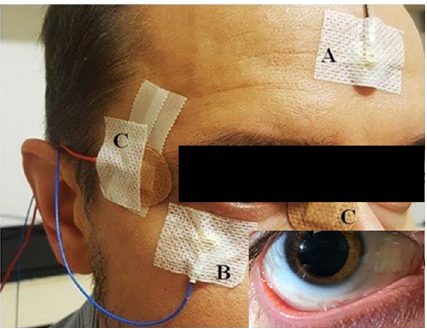
Figure 6. Illustrative position of the electrodes for ERG measurements. ( A ) Gold-cup ground electrode; ( B ) God-cup reference electrode; ( C ) DTL active electrode. For illustration purpose, small picture insert shows the position of the DTL electrode in the conjunctival